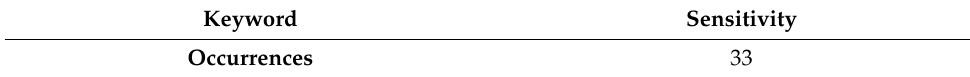
Table 9. Cluster 6 keywords and occurrences.